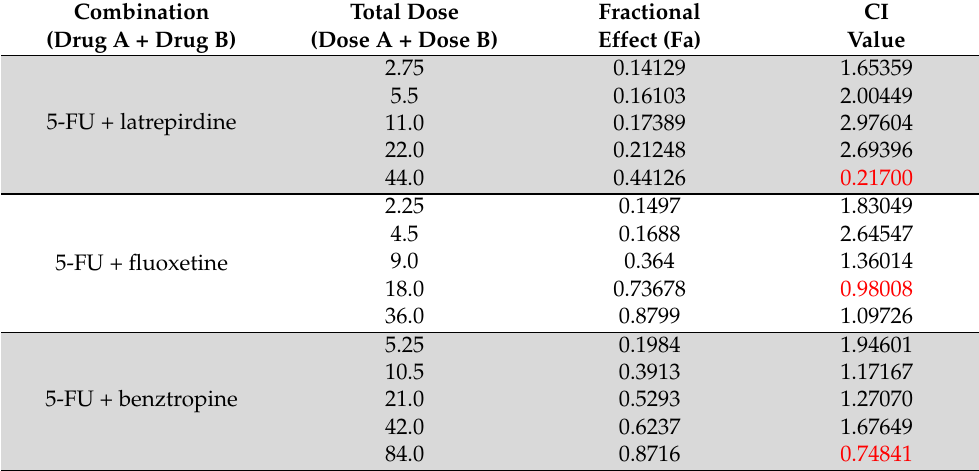
Table 3. CI values and the respective fractional effect of different combinations of 5-FU plus CNS agents and antimalarial drugs. CI in red indicates concentrations of drug pairs that are synergic. Cells were treated with 0.25, 0.5, 1, 2 and 4 times the IC 50 of each drug (total